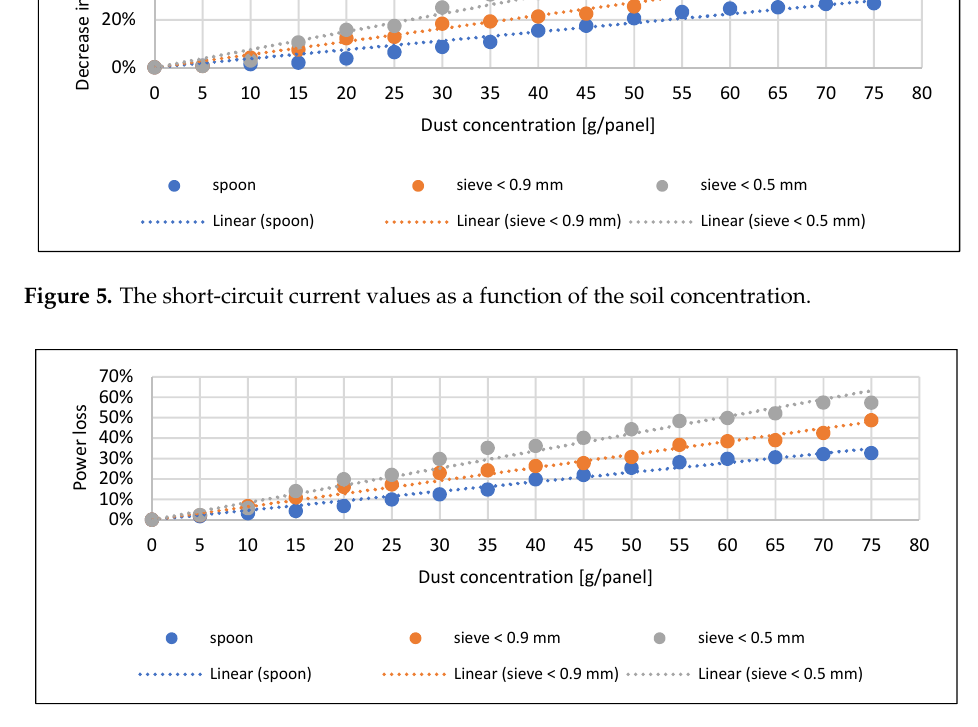
Figure 6. Power loss values as a function of the soil